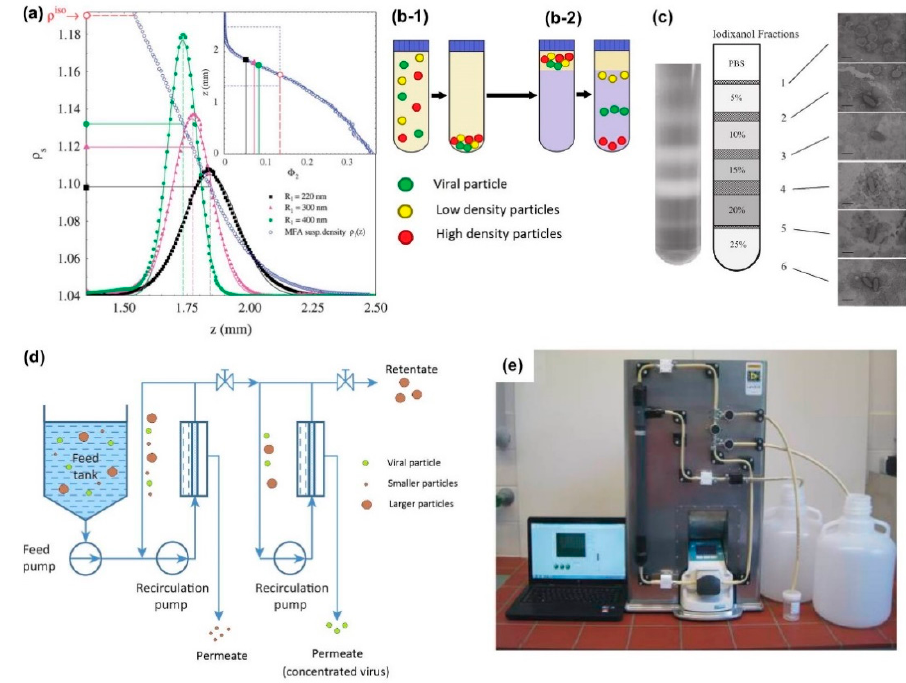
Figure 2. ( a ) Gaussian concentration profiles showing that concentration peak locations vary with particle density (reproduced from Piazza et al. [42]); ( b ) illustrations depicting a representative two-part centrifugation process: ( b-1 ) a viral sample is centrifuged, forming a pellet of solid matter; ( b-2 ) the pellet is then re-suspended over a cushion with specific density gradient and centrifuged again, separating particles by their density; ( c ) photo of a centrifuge tube ( left ) after purification of White Spot Syndrome virus from infected shrimp tissue and an illustration describing the Iodixanol density gradient. Lines projected from the illustration show corresponding TEM images ( right ) of each gradient fraction, yielding a unique distribution of subcellular debris at each fraction (reproduced from Dantas-Lima et al. [45]); ( d ) a representative filtration loop, in which the first membrane is used to remove particles smaller than the target viral particles, while the second membrane is used to remove particles larger than the target viral particles (modified from Jungbauer 2013); ( e ) photograph of a crossflow filtration loop used to concentrate MS2 bacteriophage and human adenovirus particles (reproduced from Pei et al. [48]).